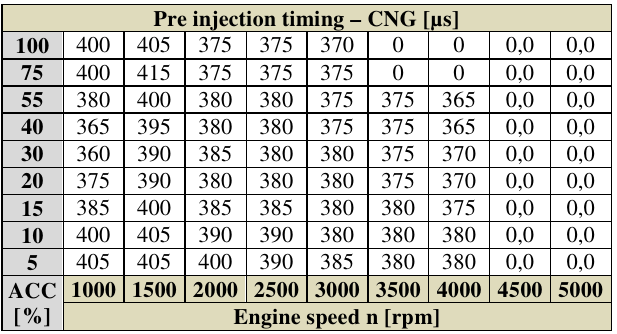
Table 12. Corrected control algorithm of opening time of Diesel oil injec- tors for Main dose at dual fuel supply of the engine Main injection timing – CNG